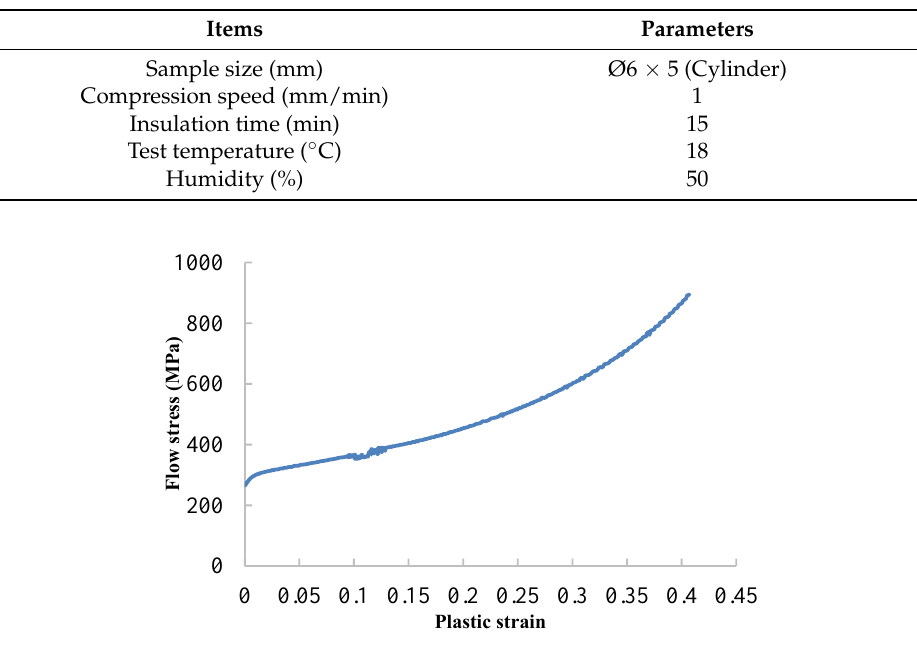
Table 5. Design of the experiment for uniaxial compression.